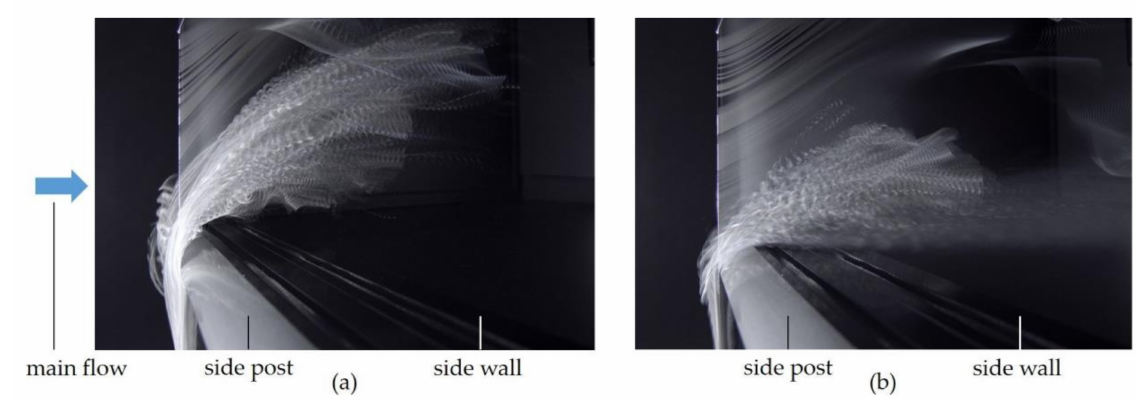
Figure 20. Streaklines in the area of side post and side wall: ( a ) Conventional fume hood with no flow control; ( b ) Baseline . S = 48 m 3 /h, C µ = fume hood with wall jets,